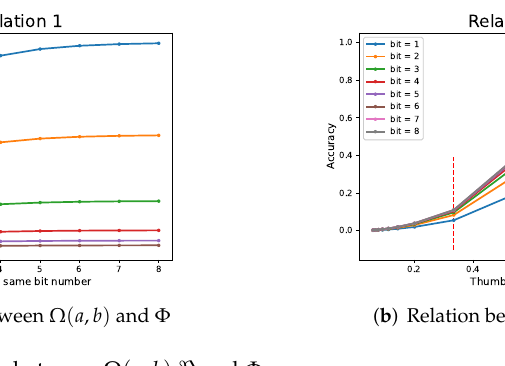
Figure 10. Relation between Ω ( a , b ) , (cid:60) and Φ .